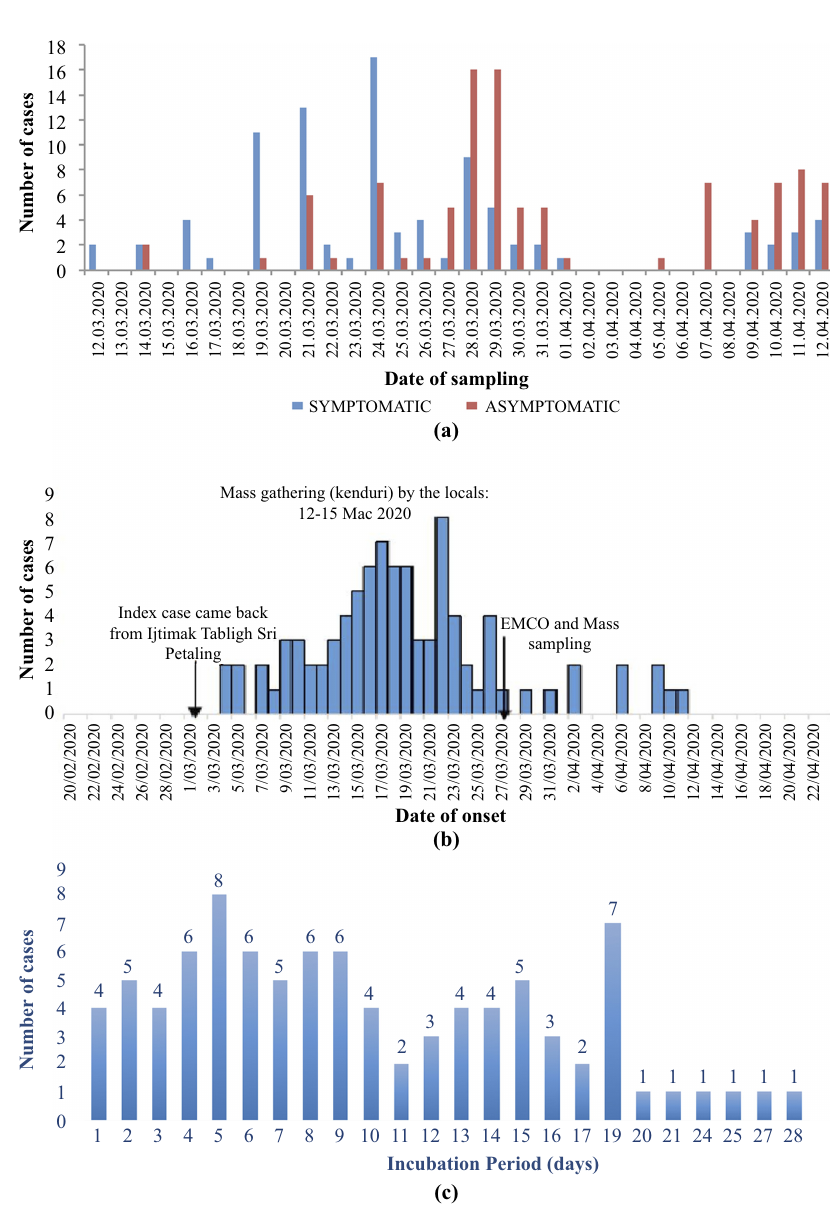
Figure 2. a - Number of cases detected by date of sampling from 12th March to 22nd April 2020 Plotted number of b - Epidemic Curve of COVID-19 outbreak in EMCO-BBIM until 27th April 2020 ( n = 90) cases over c - Number of COVID-19 cases by days of incubation period